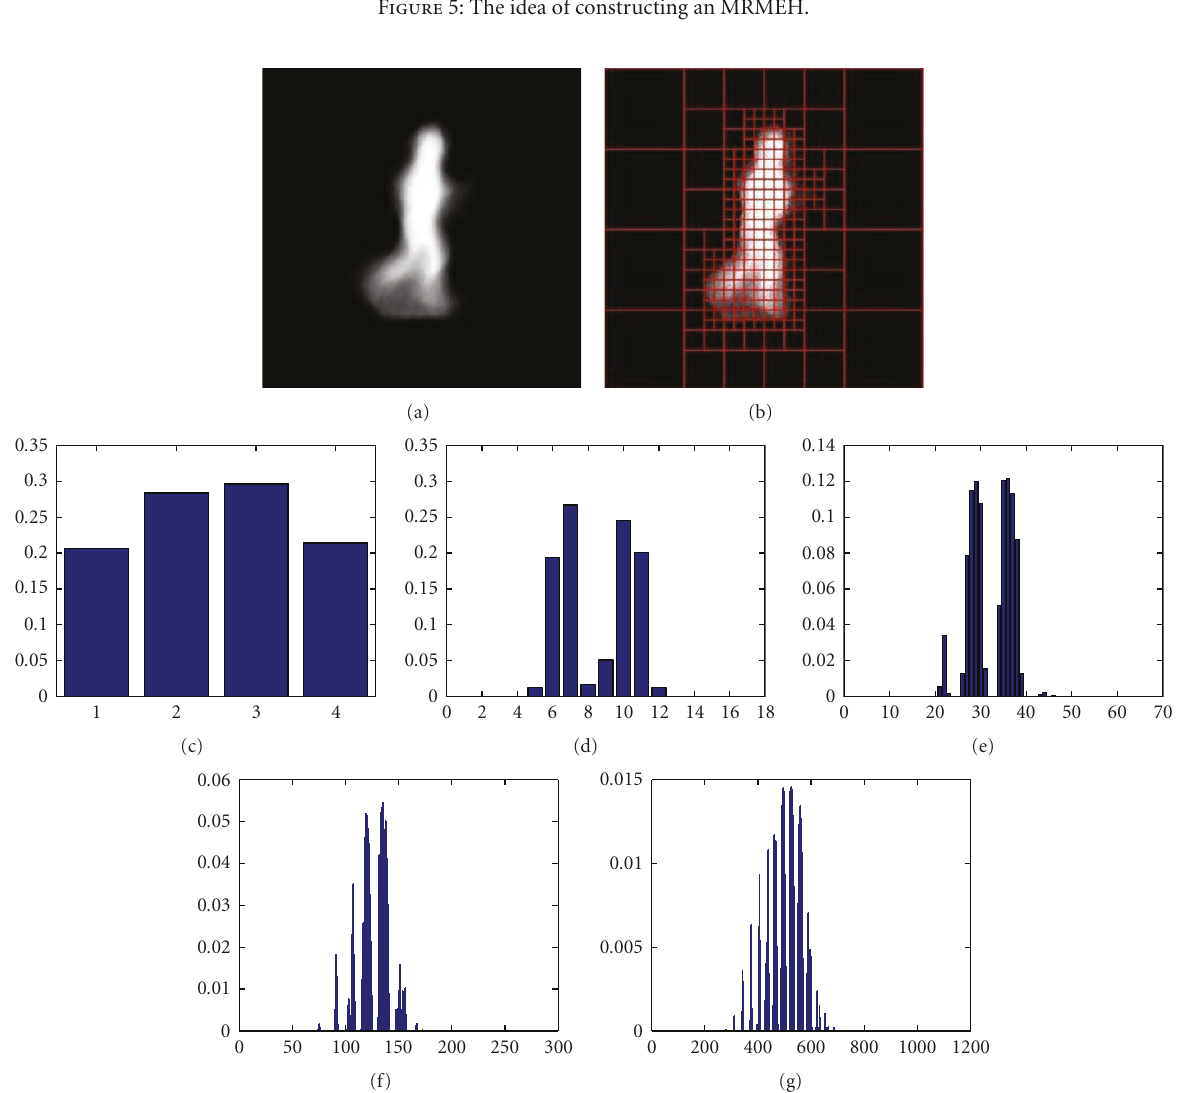
Figure 6: A five-level MRMEH for the motion “running”. (a) Original MEH. (b) Quadtree decomposition result. (c)–(g) Corresponding histogram from levels 1 to 5,